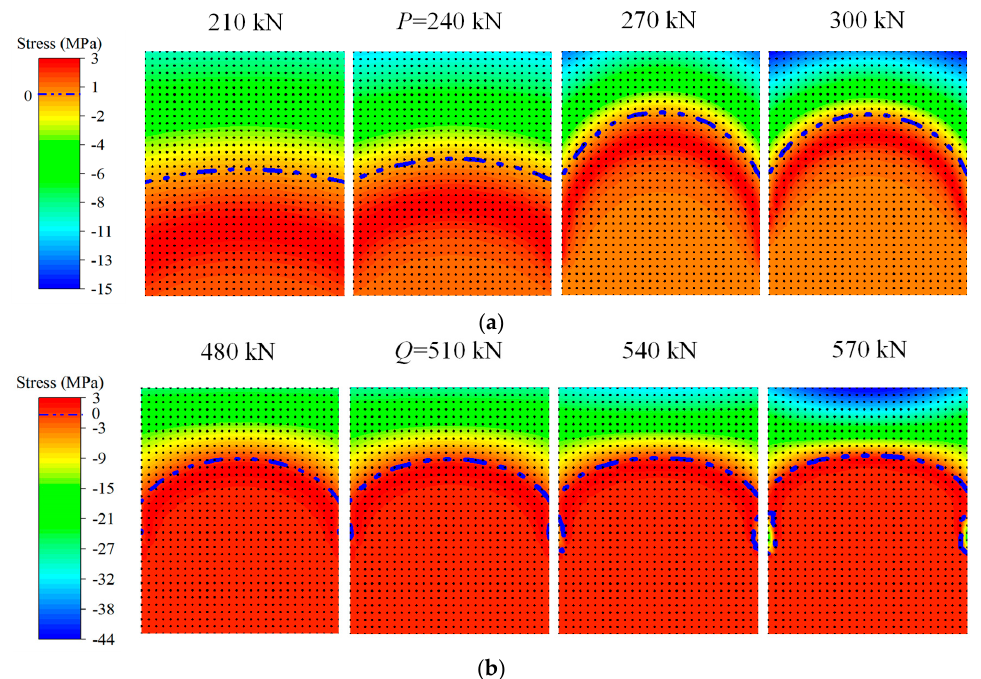
Figure 12. The stress fields of unbonded No. 4 beam (UP4): ( a ) the stress fields around characteristic point P ; ( b ) the stress fields around characteristic point Q.